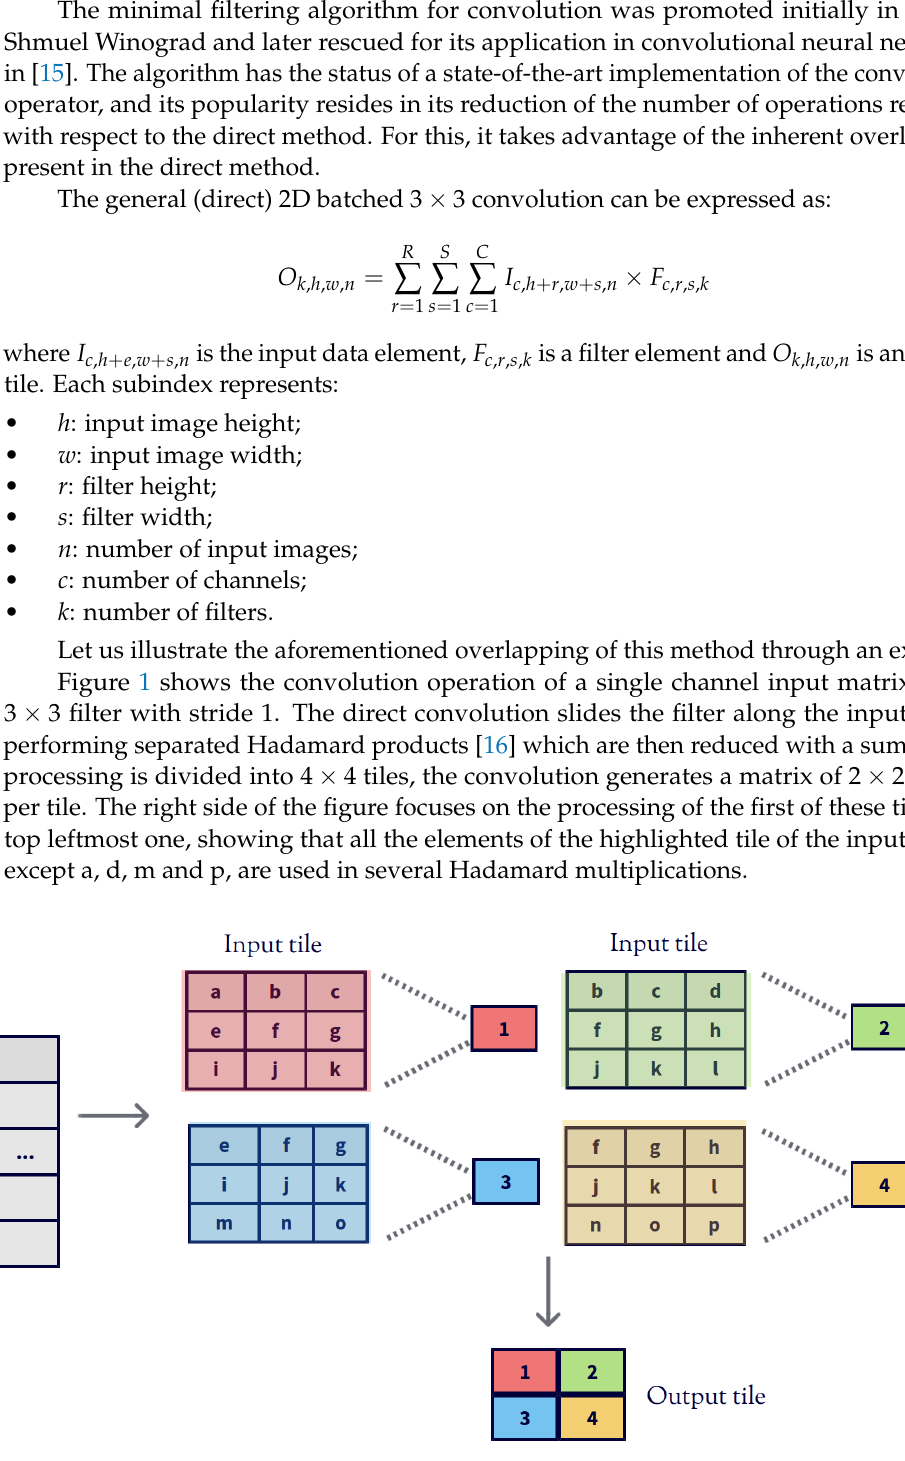
Figure 1. Traditional